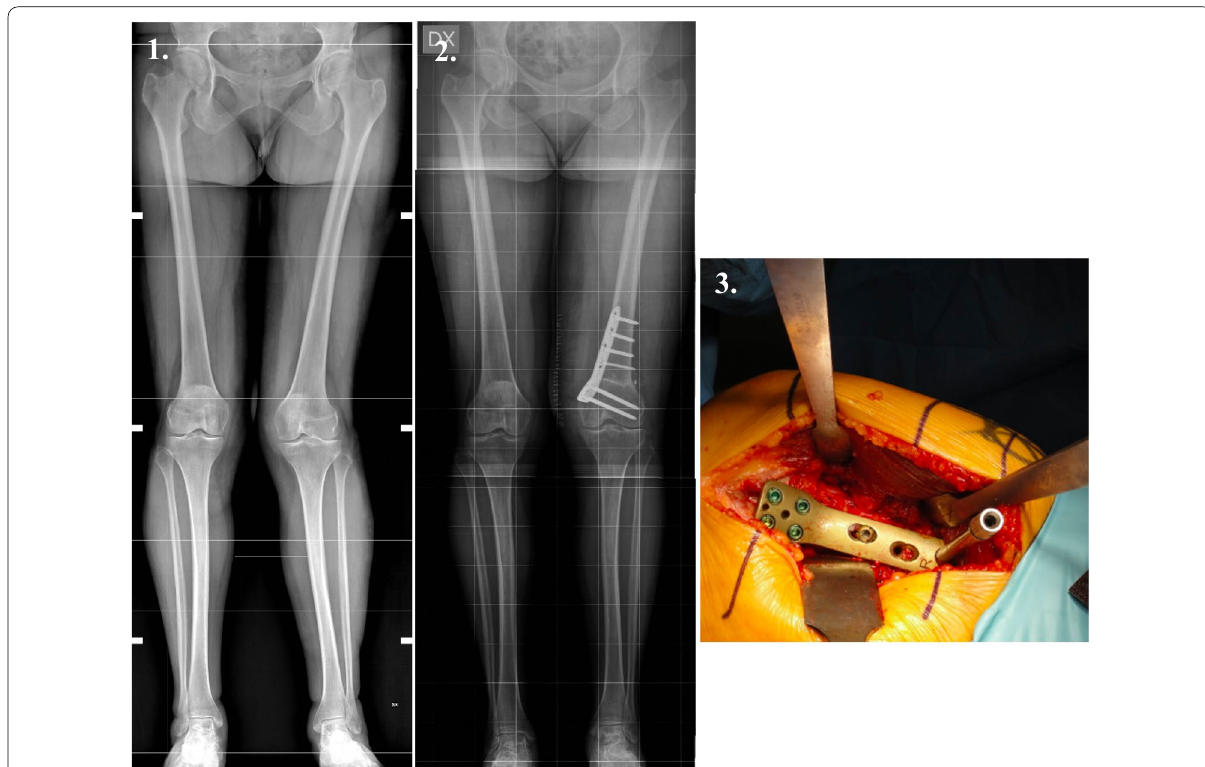
Fig. 1 Image 1 shows preoperative valgus lower limb alignment before femoral osteotomy; image 2 shows lower limb alignment after correction using a medial distal femoral plate. Image 3 shows an eight-hole Tomofix (DePuy Synthes) medial femoral condyle plate placed on the medial aspect of the femur, just after the reduction of the osteotomy